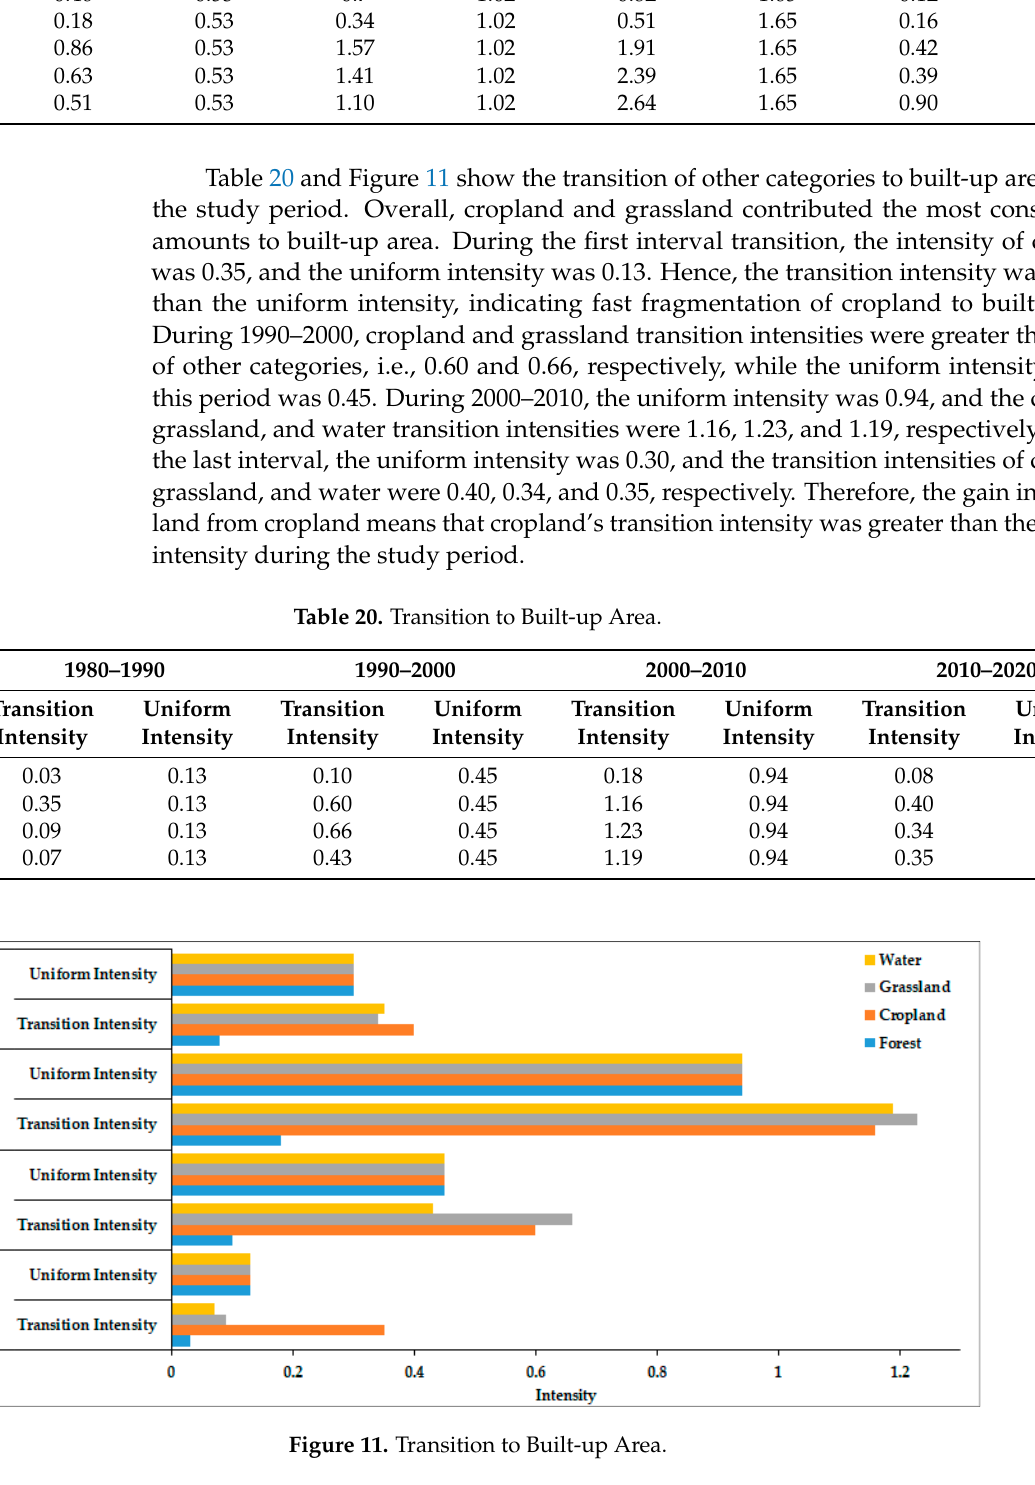
0.02 Figure 12. Transition to Forest.